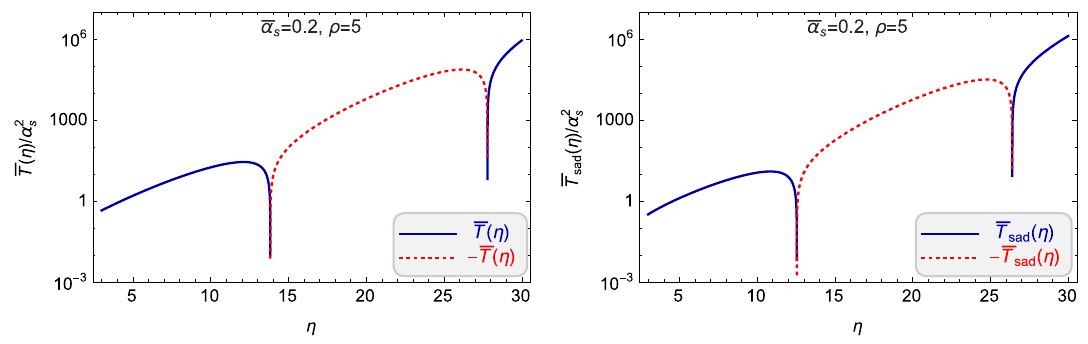
Figure 3 . The amplitude (divided by (cid:11) 2 ) as a function of the target rapidity (cid:17) and for (cid:12)xed (cid:26) > 0, s as determined from eqs. (4.16) and (4.18). Left: exact numerical solution. Right: saddle-point solution corresponding to eq.